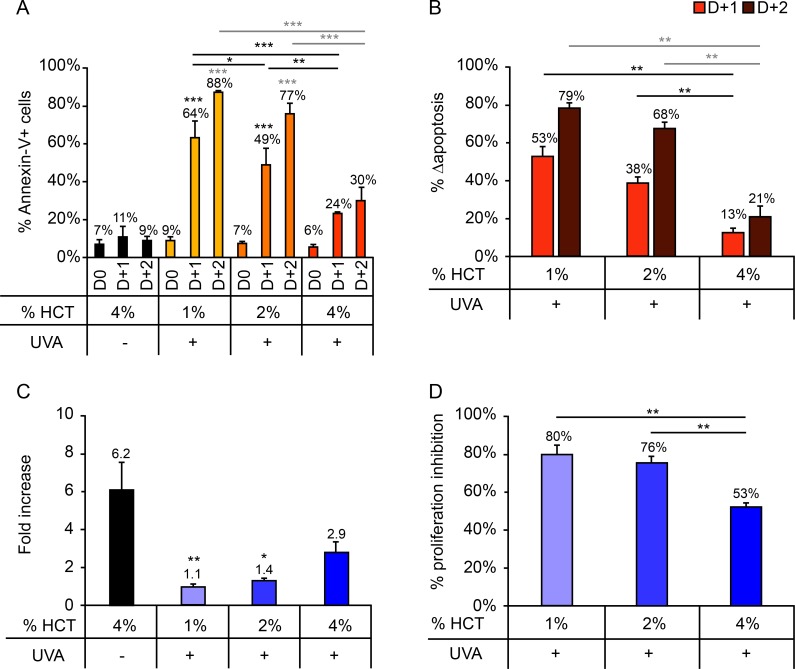
Impact of hematocrit (1%, 2%, or 4%) on cellular response after UVA irradiation (2 J/cm2).(A) Percentage of Annexin-V+ cells measured daily up to 2 days after irradiation. (B) Δapoptosis determined on days 1 and 2 post-irradiation. (C) Fold increase on day 3 post-irradiation relative to day 0. (D) Proliferation inhibition percentage, calculated as the percentage decrease in proliferation in irradiated versus control samples. For clarity, only statistically significant results are shown. *p<0.05; **p<0.01; ***p<0.001. Significant differences with respect to the control (UVA-) are indicated with an asterisk above the relevant bar, while comparisons between irradiated samples are indicated with an asterisk over a line linking the relevant bars. For Annexin-V+ cells (A) and Δapoptosis (B), comparisons performed on days 1 and 2 post-irradiation are indicated in black and gray, respectively.